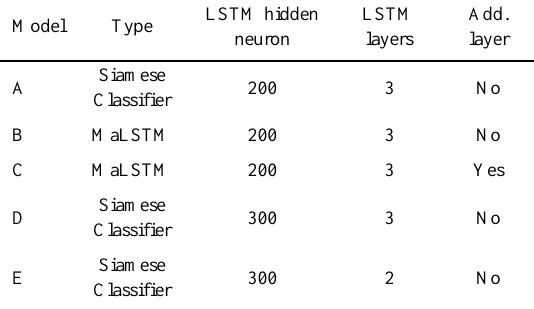
Table 4. Models architecture